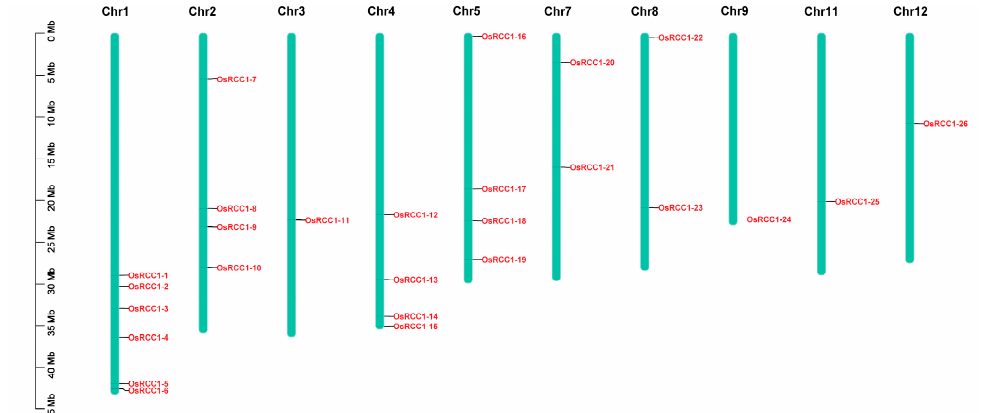
Figure 4. Chromosome distribution of OsRCC1s . Chromosome numbers are shown at the top of each chromosome, and the name of each OsRCC1 is labeled at the right side of each chromosome. Scale bar on the left side indicates the chromosome lengths (Mb).